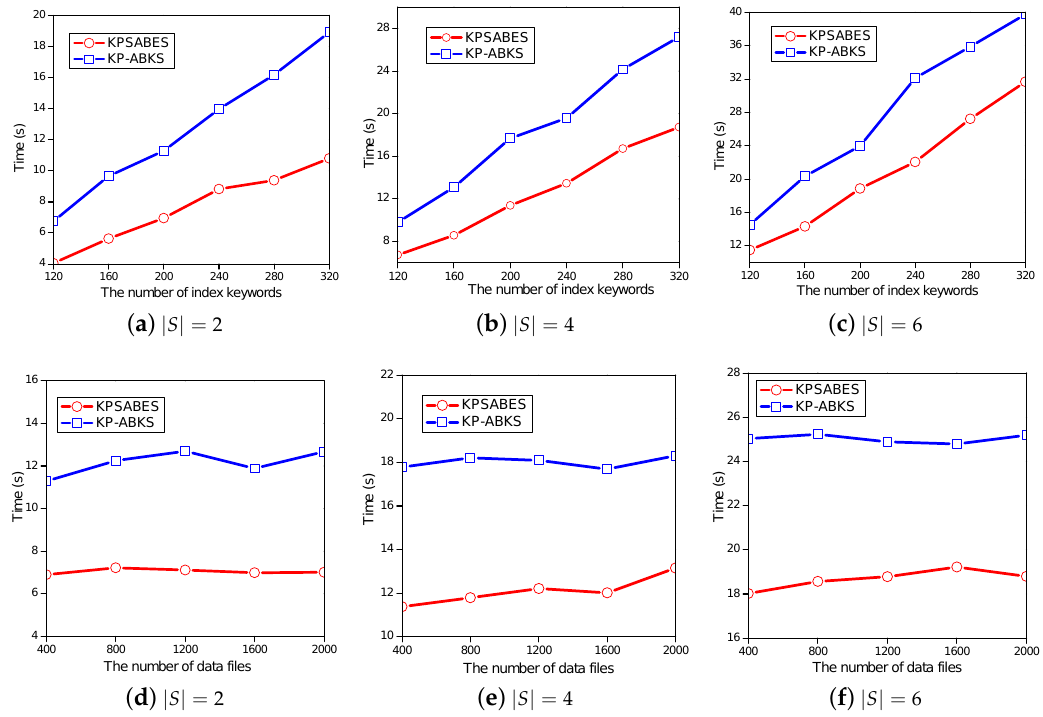
Figure 7. Time cost of Search algorithm in KPSABES and